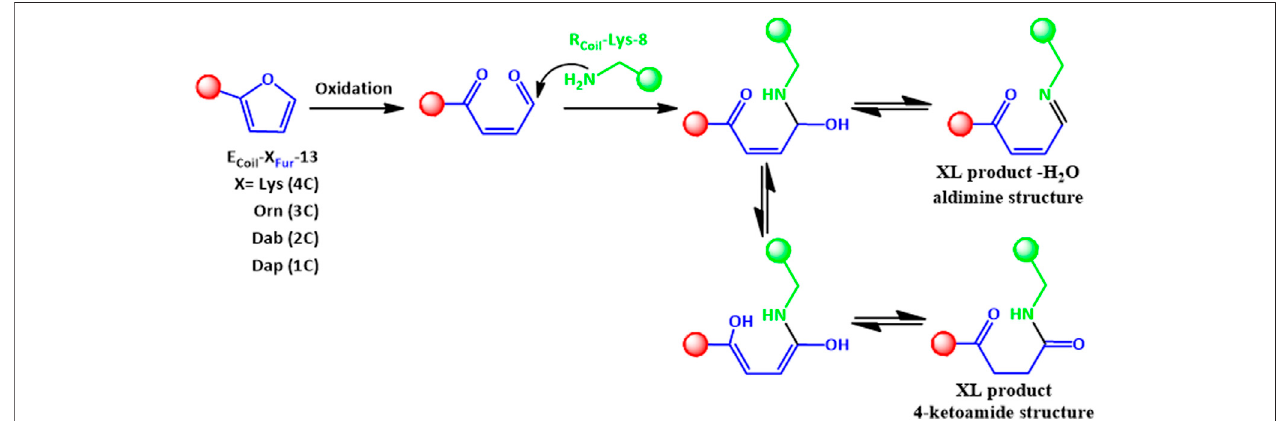
FIGURE 5 | The 4-ketoamide structure is proposed as the end product of the reaction between E Coil -X Fur -13 with R Coil -Lys-8 after furan activation, with the same exact mass as the structure described previously in Miret-Casals et al. (2021b). An aldimine species (XL product — H 2 O) can also be formed. XL refers to cross-linked species.